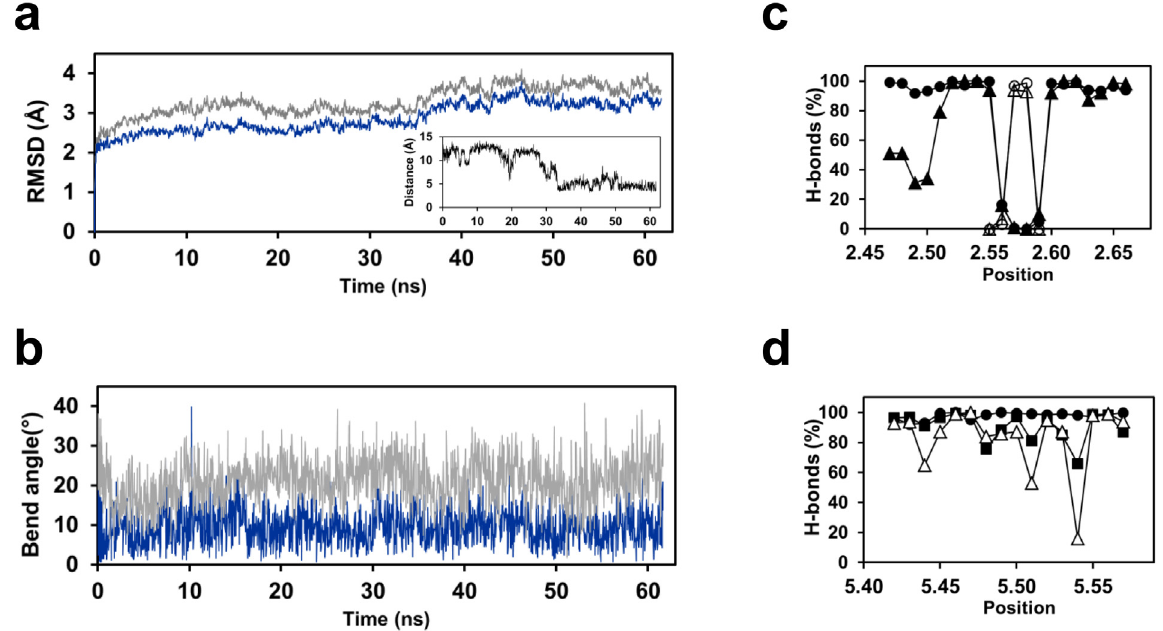
Fig 9. Analysis of the MD simulations of the TSHR transmembrane domain. (a) Time evolution of the root mean squared deviations (RMSD) of the C α atoms of the TSHR transmembrane domain (grey) or transmembrane helices only (blue). The insert shows the evolution of the distance between the C δ atom of E3.37 and the N δ 1 atom of N4.47; (b) Time evolution of the bend angle of TM2 (grey) and TM5 (blue); (c) Backbone i to i -4 (closed symbols) and i to i - 5 (open symbols) H-bonds in TM2. The percent of H-bonds was measured during the equilibration phase (triangles) and the production run (circles); (d) Backbone i to i -4 H-bonds in TM5 during the equilibration phase (triangles), the 35 first ns (squares) and the 25 last ns (circles) of the production run.